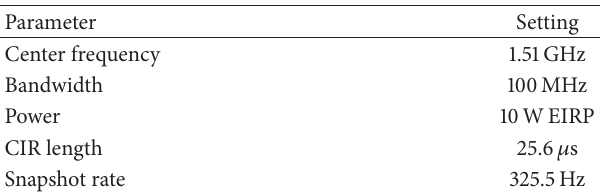
Table 1: Sounder settings for the land mobile channel measurement